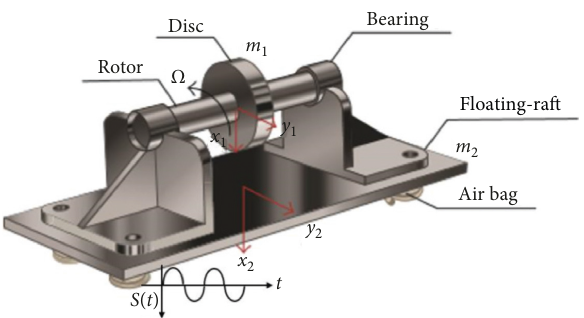
Figure 1: Dynamic motion model.